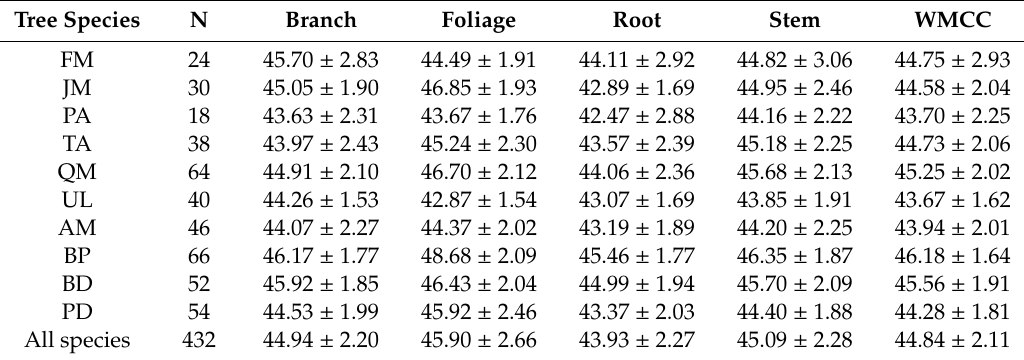
Table 2. Means and standard deviation (SD) of tissue-specific carbon concentration of the 10 tree species. Tree Species